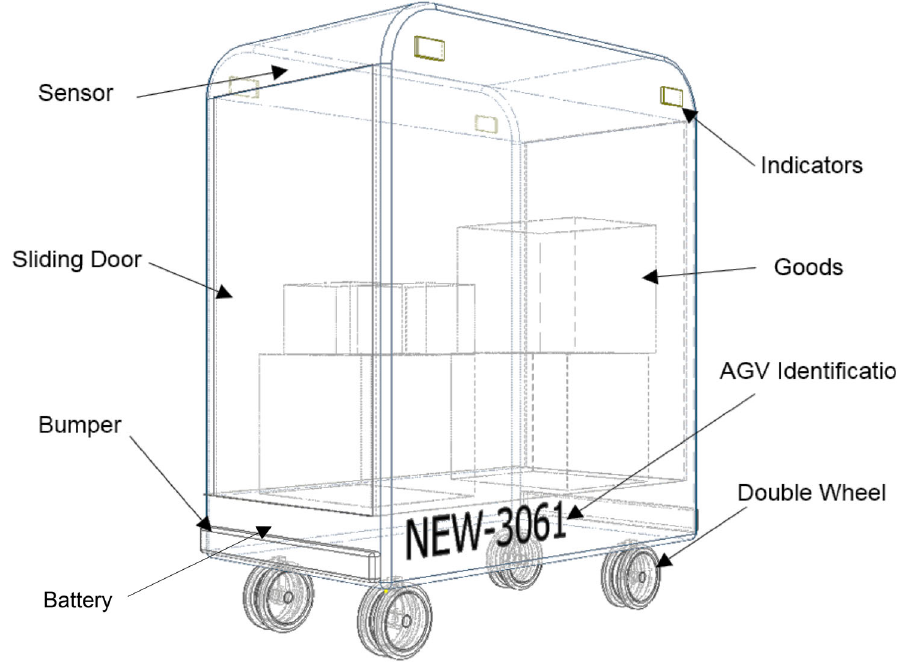
Fig. 20 Metro automatic guided